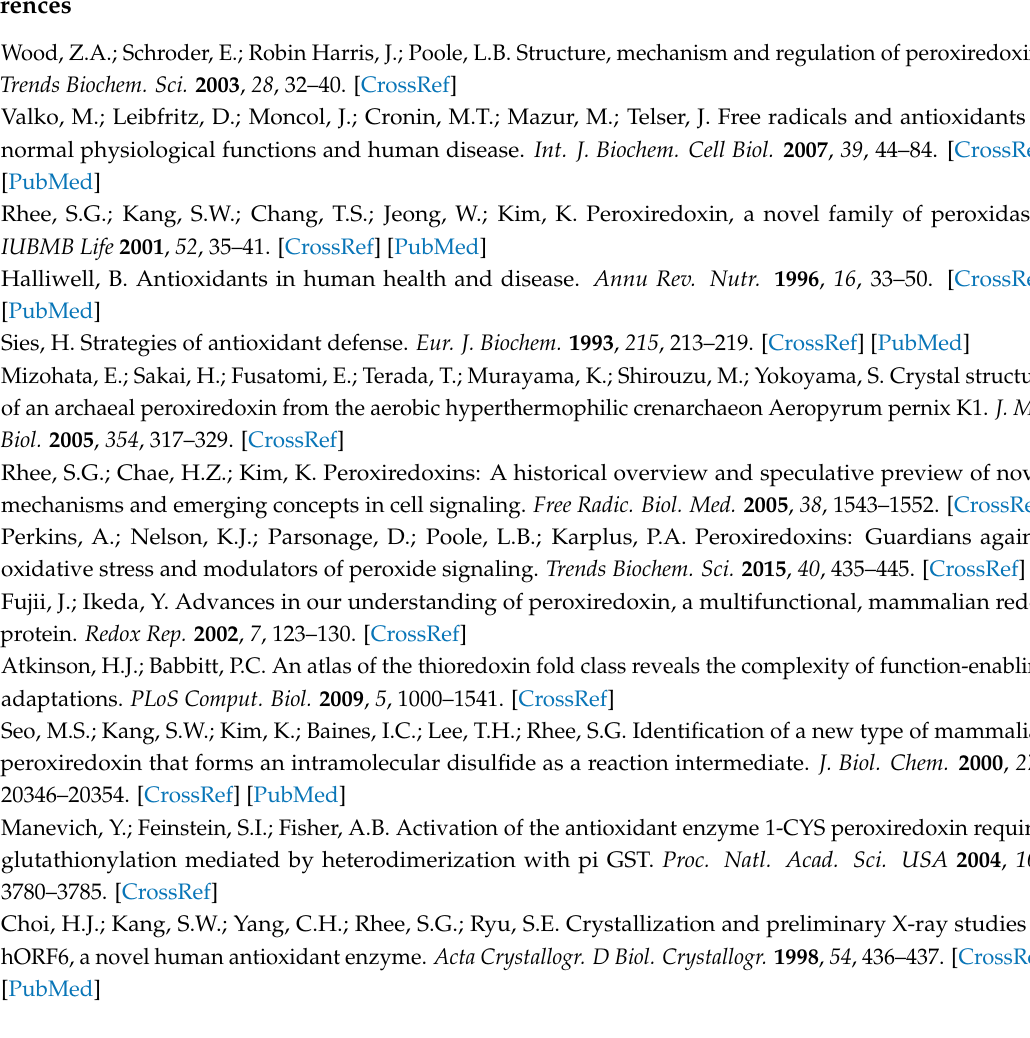
Figure S1: Ramachandran plot of rat Prdx6 model generated using Procheck. Figure S2: Graphical representation of the absolute quality of rat Prdx6 model evaluated by QMEAN